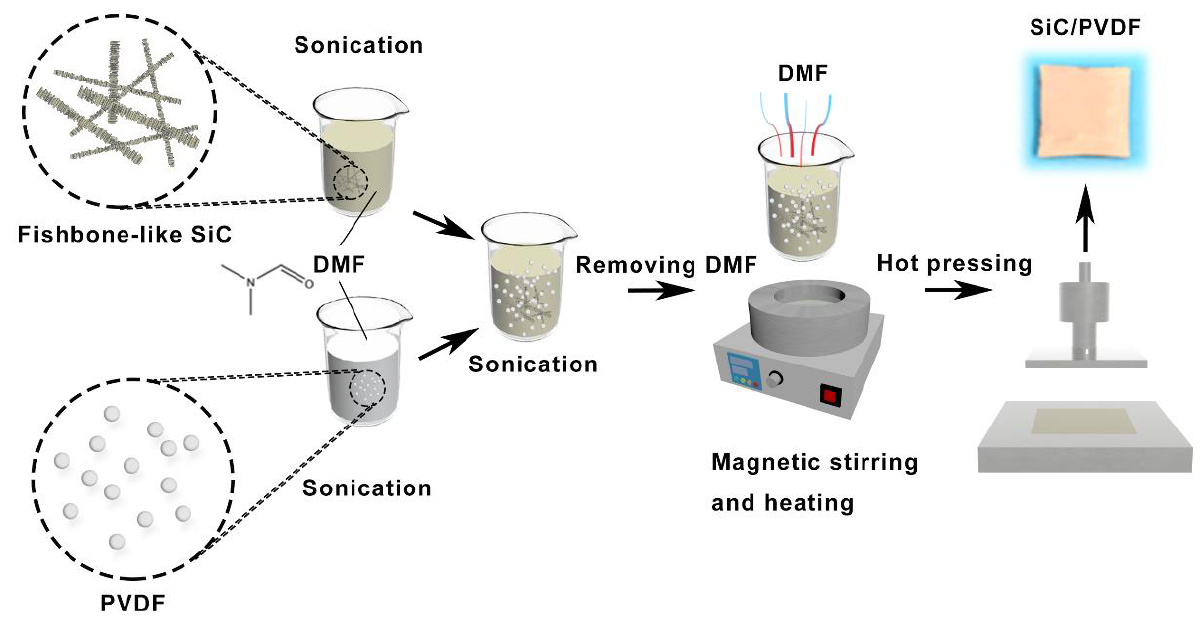
Figure 1. Preparation process of SiC/PVDF composites.